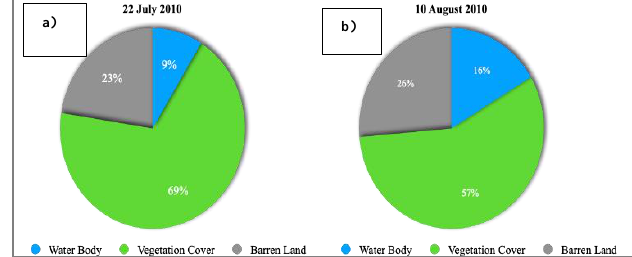
Figure 6: (a) identify pre-flood percentage changes in different land cover and (b) determine post-flood percentage changes in different land cover of the study area